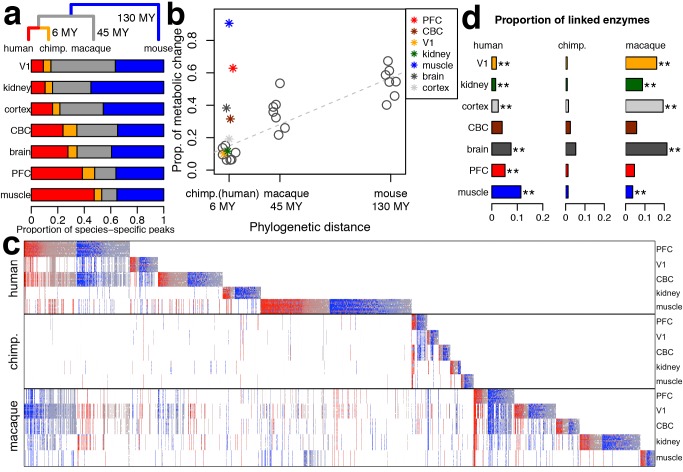
Species-specific metabolic change.(a) Proportions of metabolite concentration changes on the four species evolutionary lineages. The phylogenetic tree above the bars shows the human (red) and chimpanzee (orange) evolutionary lineages, the lineage connecting the common ancestor of humans and chimpanzees with macaques (gray), and the lineage connecting the common ancestor of humans, chimpanzees, and macaques with mice (blue). The colors within the bars show proportions of metabolite peaks with concentration changes specific to the corresponding lineages. (b) Relationship between species-specific metabolite concentration divergence in each tissue and the corresponding phylogenetic distances in million years (MY). The linear regression between metabolite concentration divergence and phylogenetic distances represented by the dashed line was calculated based on the proportions of metabolite peaks with significant concentration divergence on the corresponding lineage for the three nonhuman species (represented by circles). Asterisks colored according to the tissues show the proportions of metabolite peaks with significant concentration divergence on the human lineage relative to the chimpanzee linage. (c) Heat map of relative metabolite concentration levels across three primate species. The plot is based on the 4,698 metabolite peaks that showed significant concentration differences in any tissue in the three primate species (t-test, permutation p<0.01). The columns represent metabolite peaks; the rows represent 190 tissue samples sorted by species and tissue identity. For each peak, concentration level in a given sample was normalized to the concentration across all samples of other primate species within the same tissue (base 2 logarithm-transformed ratios). The colors show positive (red) and negative (blue) concentration differences from the mean expression level. Concentration levels, p-values and annotation of the peaks shown in the Figure are listed in Table S7. (d) Proportions of enzymes with matching species-specific expression profiles linked to species-specific metabolites in a given tissue normalized by the number of enzymes with expression profiles specific to any species in this tissue. Tissues showing significant overrepresentation of enzymes with matching species-specific expression profiles are indicated with asterisks: **, p<0.01 and *, p<0.05.